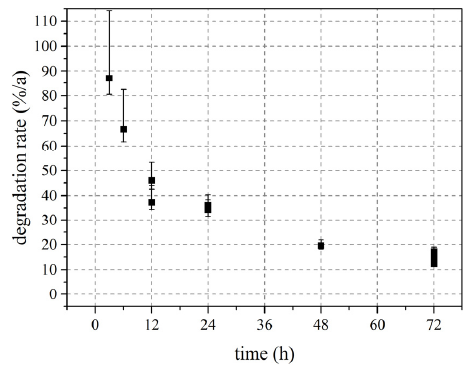
Figure 8. Degradation rate depending on time ( T = 420 °C).